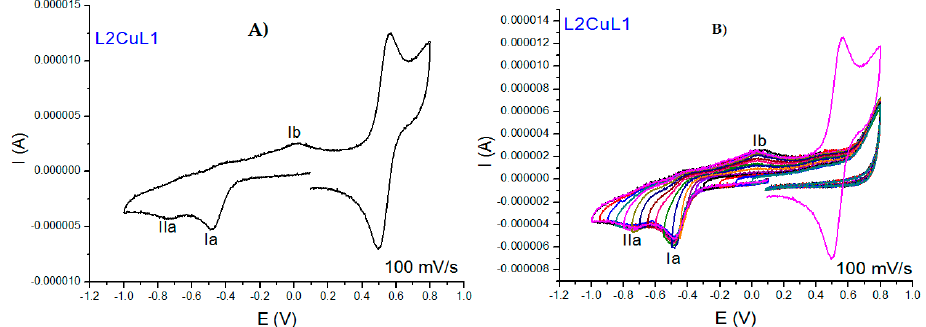
Figure 7. Cyclic voltammograms for 0.001 M of L2CuL1 in DMSO with 0.1 M tetrabutylammonium hexafluorophosphate. ( A ) voltammograms at 100 mV/s and ( B ) inversion study at 100 mV/s. All the experiments were referenced to the pair Fc + /Fc .